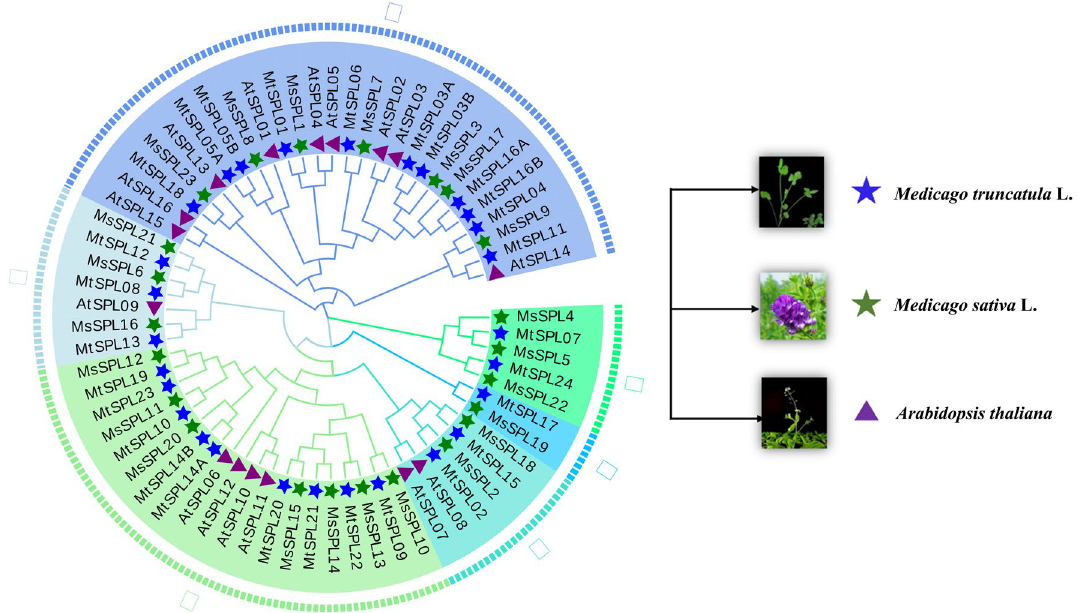
Figure 2. Phylogenetic analysis of M. sativa , M. truncatula and A. thaliana . Proteins with SBP domains from M. sativa (Ms), A. thaliana (At) and M. truncatula (Mt) were searched and named SPL. Different colors represent different clades, green stars mark SPL gene family members in M. sativa , blue stars mark SPL gene family members in M. truncatula , and purple triangles mark SPL gene family members in A. thaliana